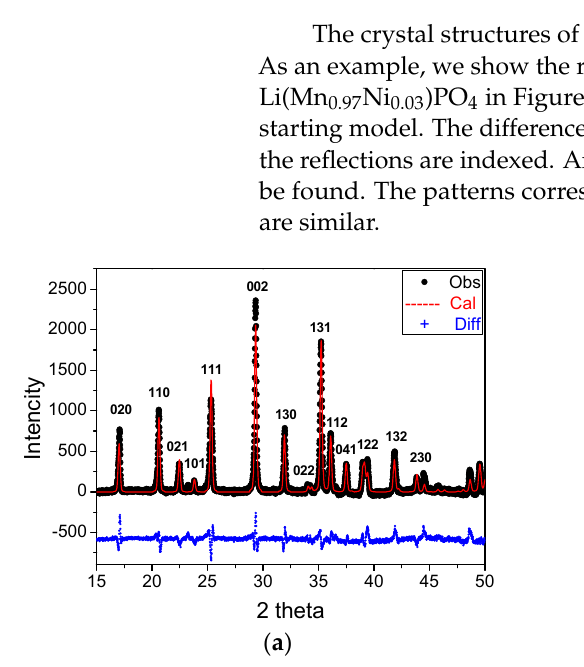
Figure 5. ( a ) Results of fitting the X-ray powder diffraction data of Li(Mn 0.97 Ni 0.03 )PO 4 : experimental (points), calculated (solid line), and difference (bottom); ( b ) Lattice parameters and unit-cell volumes of Li(Mn 1- x ,Ni x )PO 4 with different Ni-doping concentrations.